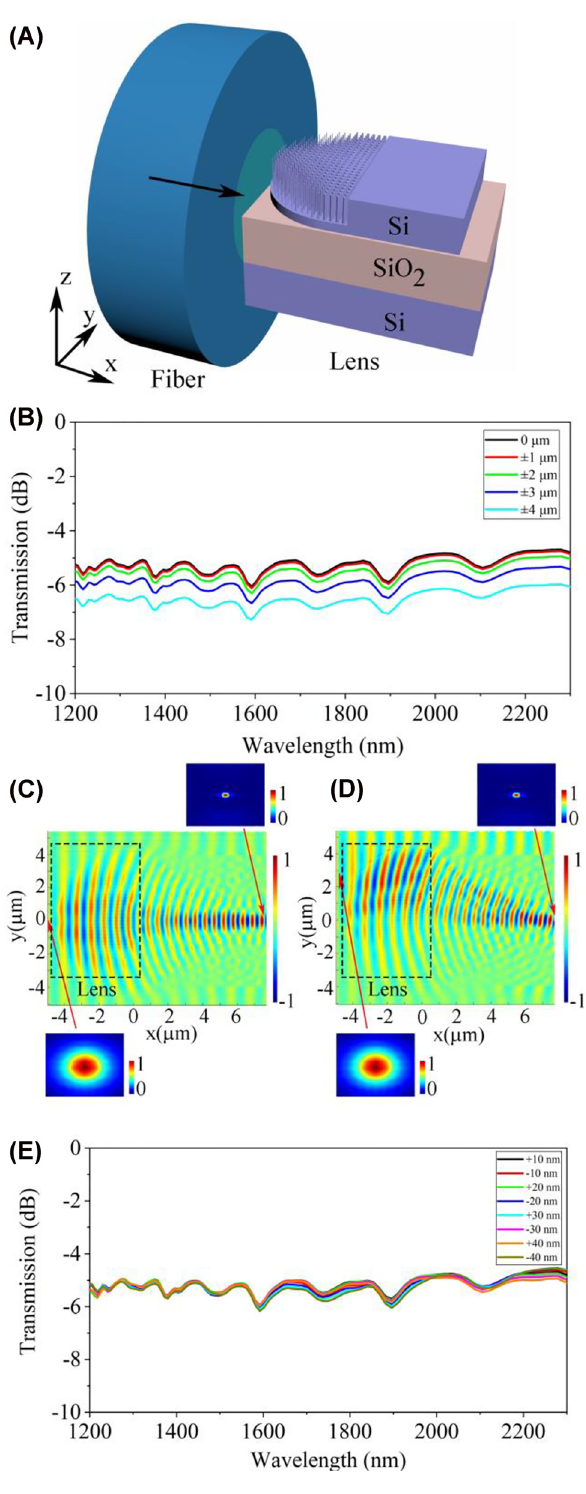
Figure 5: Simulated performance of the on-chip GRIN metalens for fiber-to-chip edge coupling. (A) Schematic of the fiber-to-chip edge coupling device. (B) Simulated coupling responses of the on-chip GRIN metalens for different relative positions of the fiber. (C) ) of the on-chip devices when Xy -plane electrical field distribution ( E y the relative position of the fiber is not shifted. (D) Xy -plane electrical